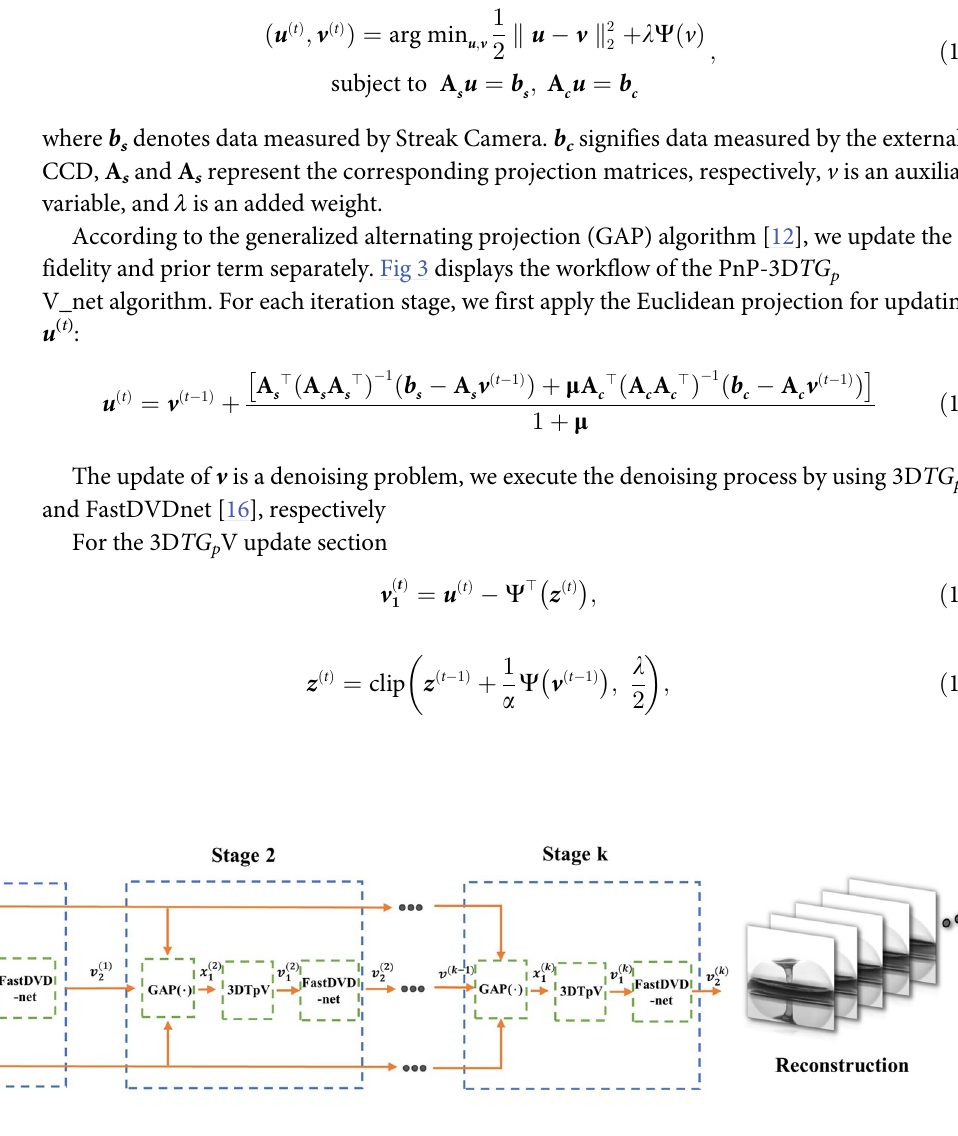
Fig 3. Workflow of the PnP - 3 DTG p V_net algorithm.